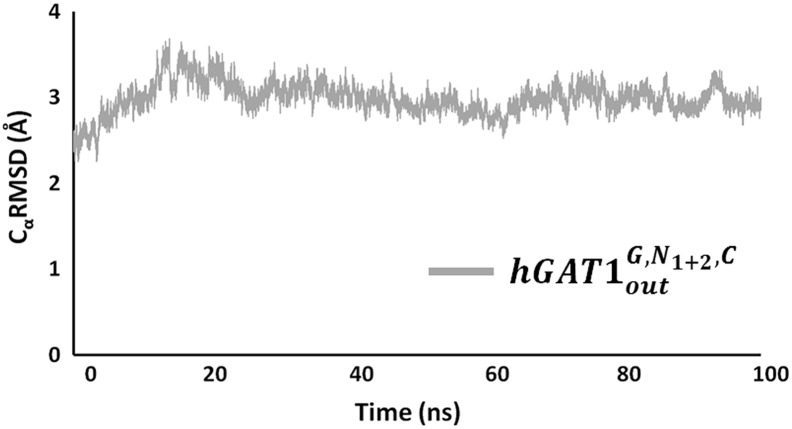
Extended MD simulation of fully loaded hGAT1 (hGAT1outG, N1+2, C) to 100 ns.